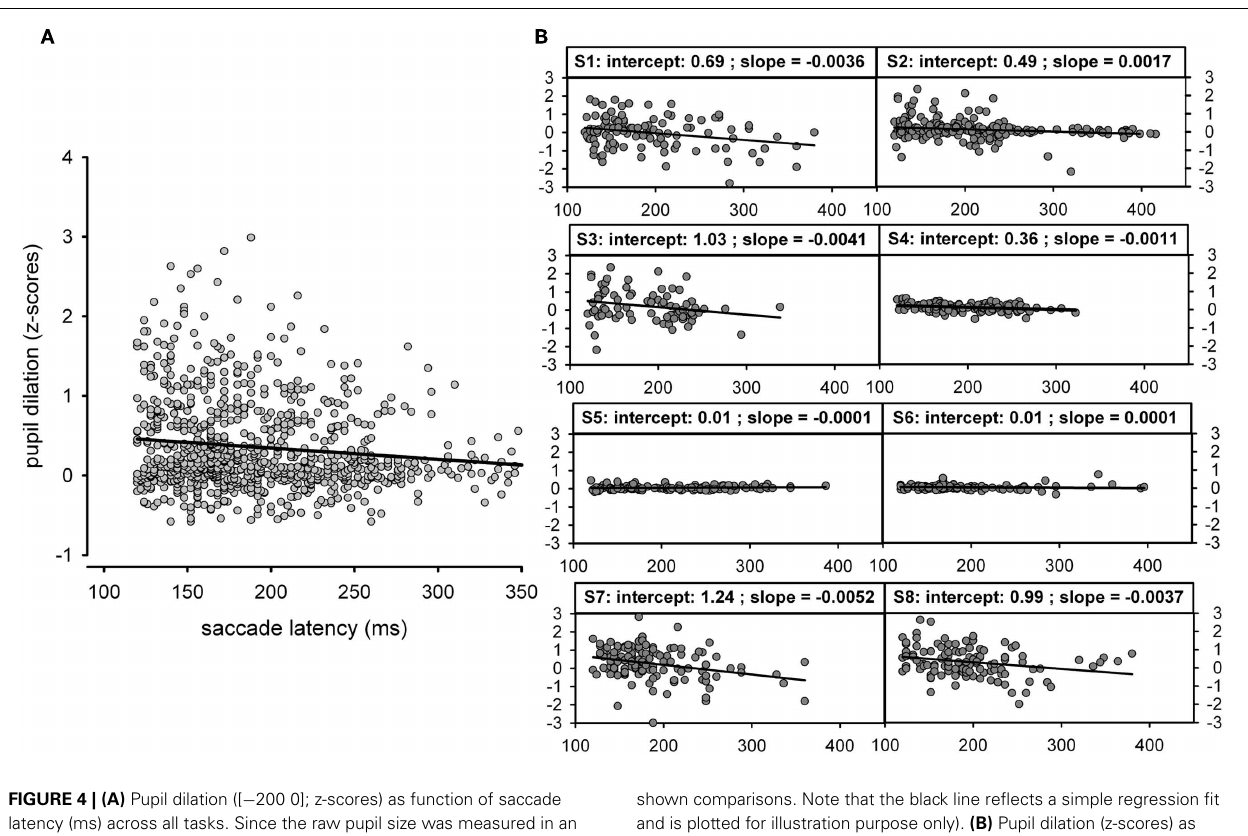
FIGURE 4 | (A) Pupil dilation ([ − 200 0]; z-scores) as function of saccade latency (ms) across all tasks. Since the raw pupil size was measured in an abritrary units (pixel) we decided to analyze the pupil size in z-scores; for saccade latencies we kept the unit (ms) as meaningful unit even for the